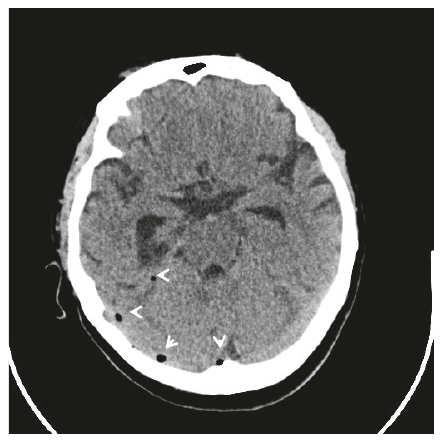
Figure 2: High resolution axial CT showing a focal osseous defect in the posterior mastoid (arrow).